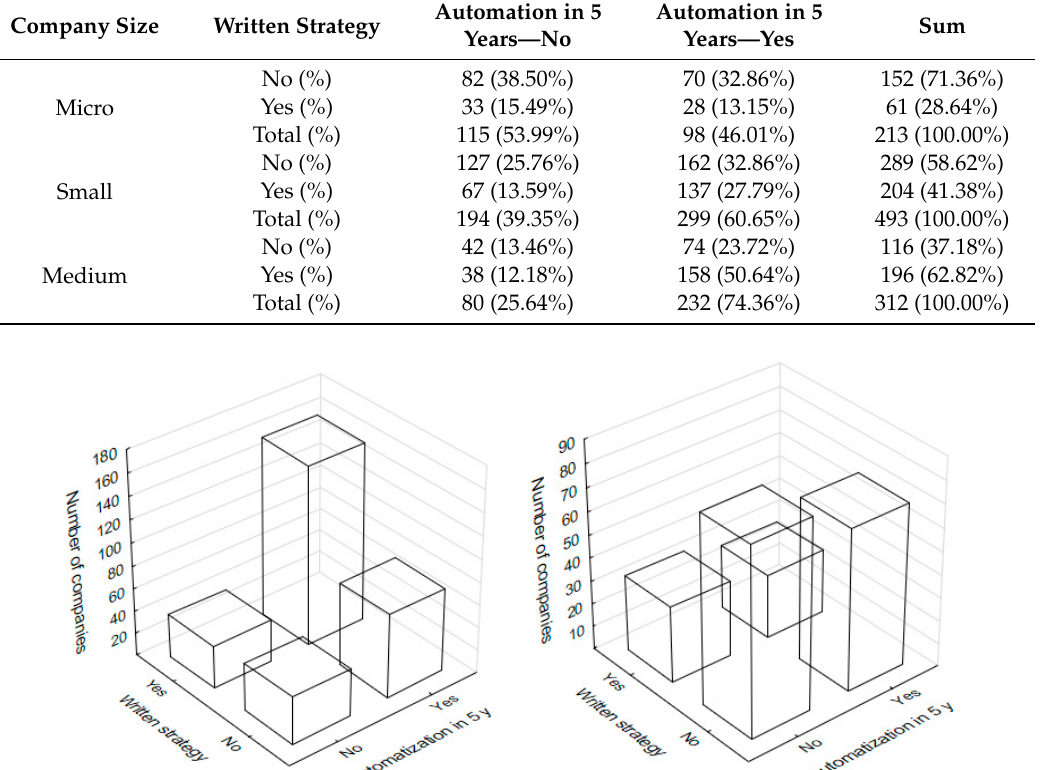
Table 2. Frequency comparison in SMEs.